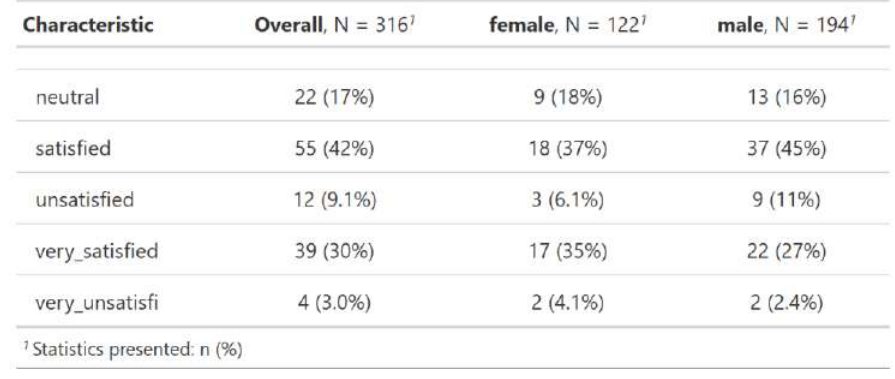
Table 11: How likely are you to recommend fellow Afghans to India for health treatment? (Source: Authors‟ depiction